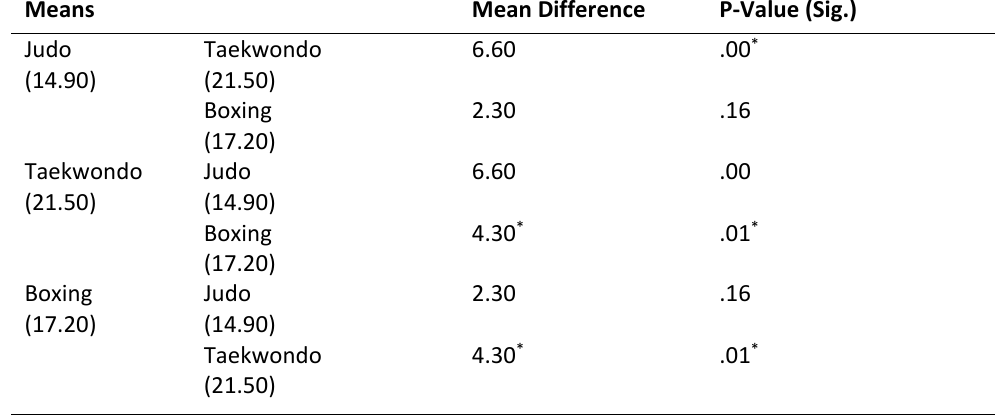
Table 8. Analysis of least significant difference (LSD) post-hoc test among judo, taekwondo and boxing players on the sub-parameter preparation